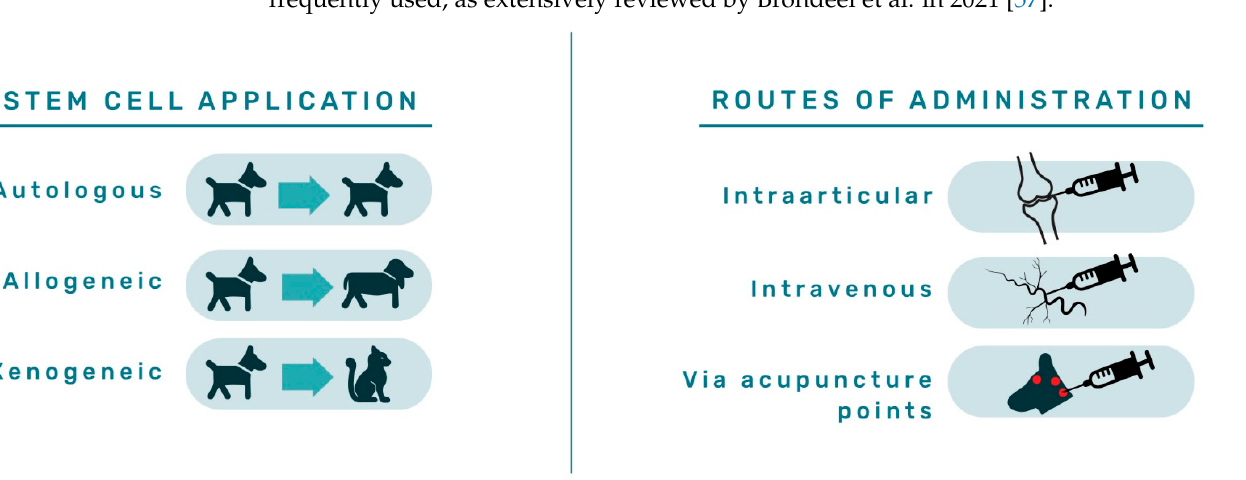
Figure 6. Graphical presentation of canine adipose-derived mesenchymal stem cell application strategies and routes of administration applied within available studies described in the literature.